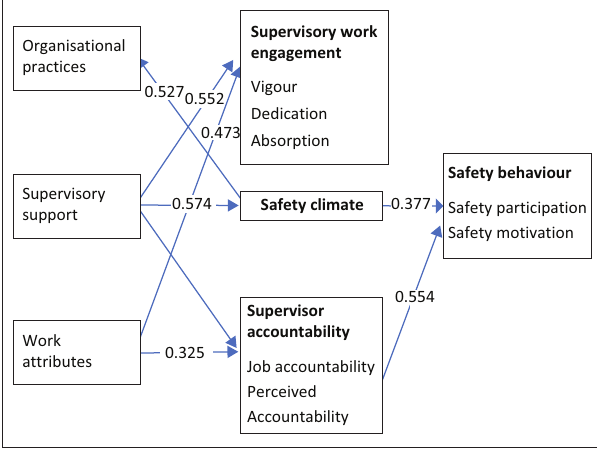
FIGURE 1: Proposed model using validated factor structure and indicating hypotheses with associated correlation